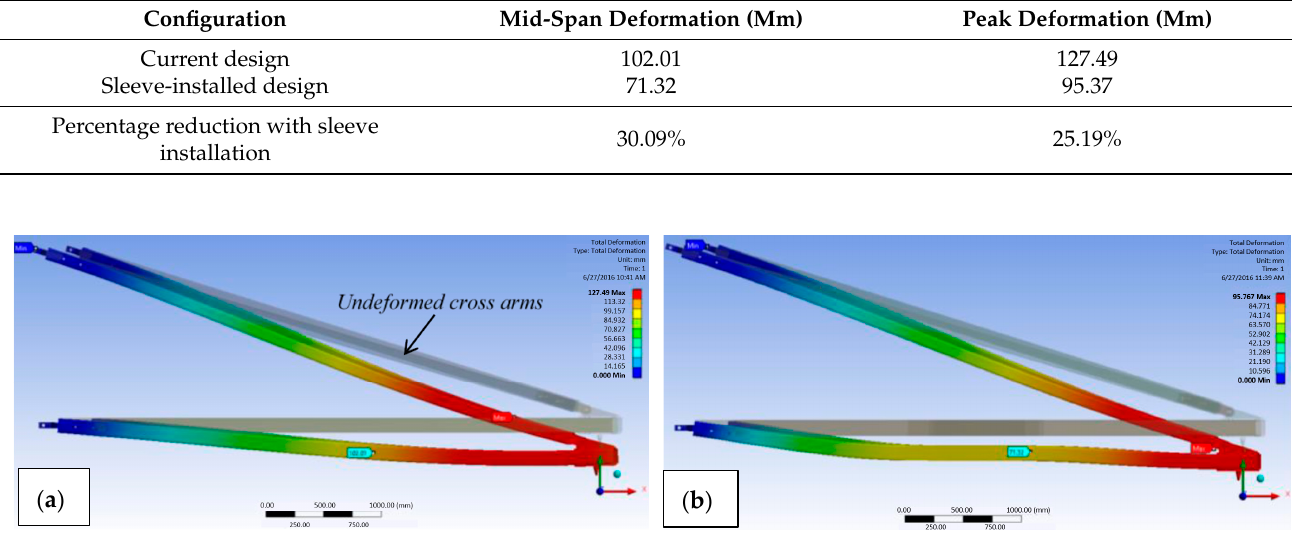
Figure 12. Deformation of ( a ) the current composite cross arm and ( b ) the sleeve-installed cross arm as subjected to multiaxial static loading [66]. Table 5. Deformation results of both composite cross-arm configurations [66].